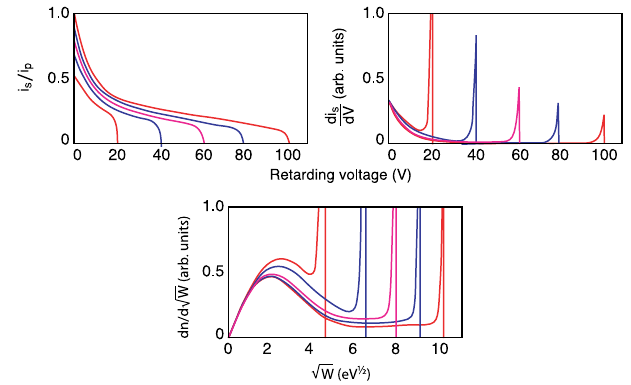
FIG. 3. Energy distribution of secondary electrons emitted by copper [27], its analytically obtained derivative, and distribution with respect to square root of energy. Energy of primary elec- trons is from 20 to 100